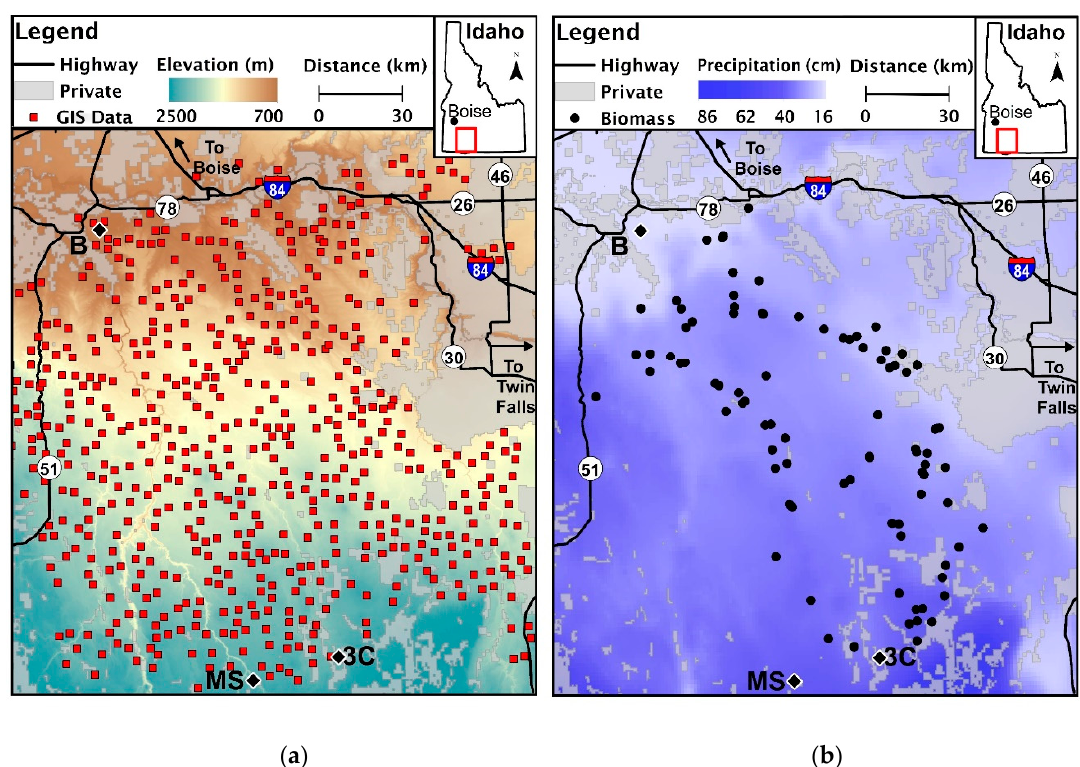
Figure 1. The study area located in southern Idaho, U.S.A., the center of which is approximately 65 km due west of Twin Falls. Red squares ( a ) indicate locations where we extracted fire regime characteristics and environmental data from geospatial layers along the elevation gradient (n = 573). We collected biomass from 67 field locations ( b ) along the precipitation gradient (n = 67). We indicate the location of weather stations used in examining regional climate: Bruneau ( a , b ), Muphy Hot Springs (MS), and Three Creek (3C).